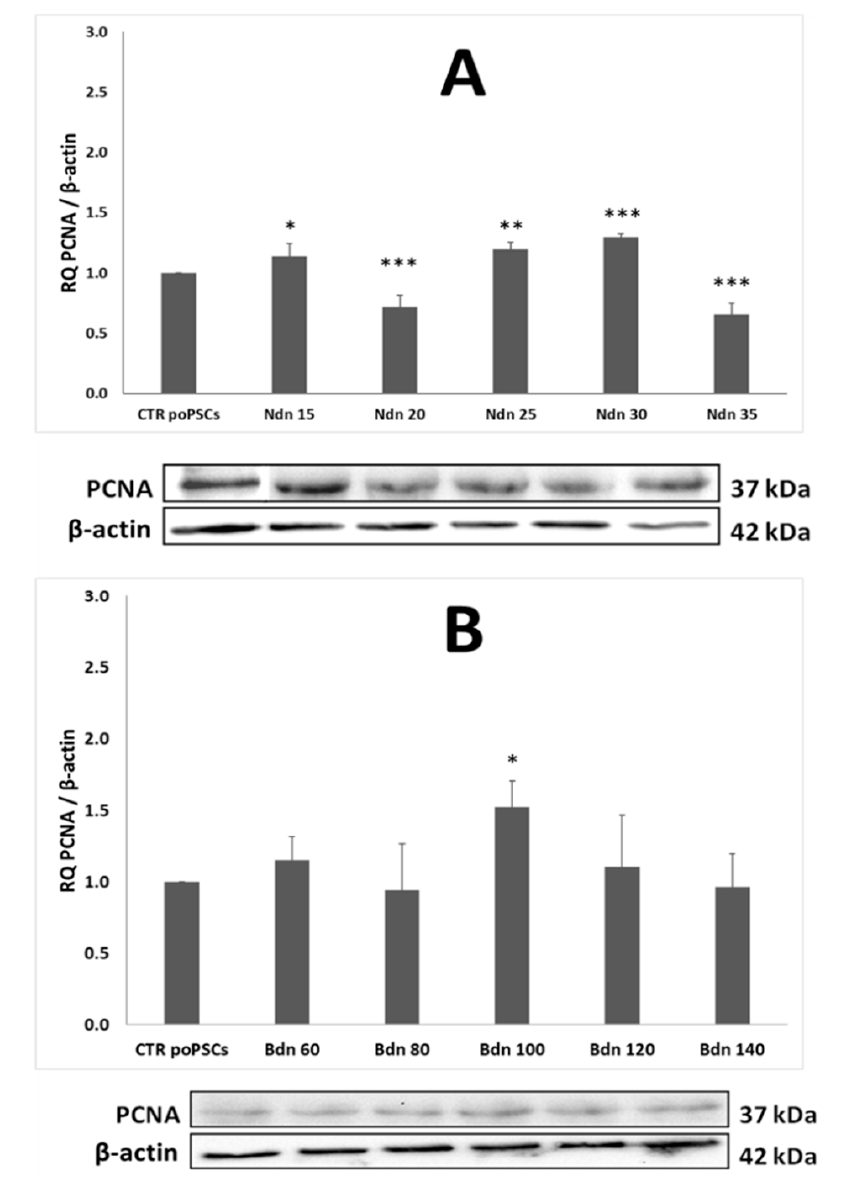
Figure 2. PCNA proliferation marker expression at the level of total protein isolated from poPSCs grown at different concentrations of nandrolone ( A ) and boldenone ( B ). The graphs show the relative content of PCNA protein obtained from measurements of the optical density of the bands representing a specific signal. Results represent the mean with n = 5 ± standard deviation (SD). Statistical analysis: homogeneity of variance—Levene’s test, normality of distribution—Shapiro–Wilk test, one-way ANOVA, and Duncan’s post-hoc test: part of the differences on the level of PCNA expression was statistically significant as follows: * p < 0.05; ** p < 0.01; *** p < 0.001. N 15-N 35: applied doses of nandrolone in concentrations ranging from 15 µ M to 35 µ M; B 60-B 140: doses of boldenone used in concentrations ranging from 60 µ M to 140 µ M, CTR poPSCs-control culture without the addition of anabolic